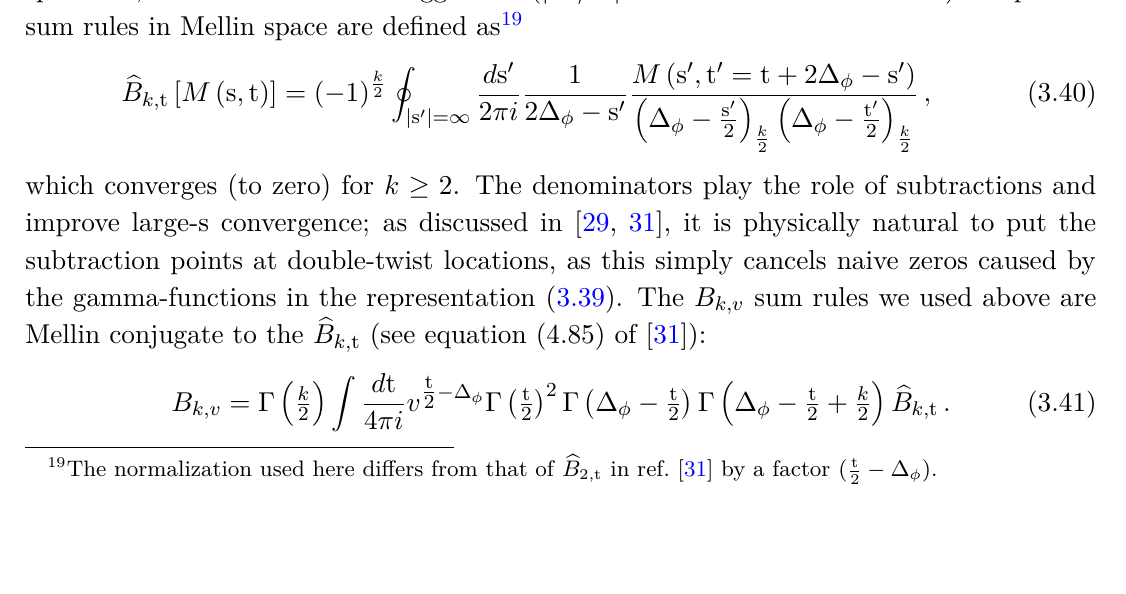
Figure 9. Interpretation of the complex saddle point (3.33) and spacelike scattering. We start with the commutator squared h [3 , 4][1 , 2] i ∼ dDisc ure 7(b). The s -channel OPE inserts a basis of intermediate states along the dashed line, which propagate horizontally along a spacelike direction. This explains why a real exponent appears in the block (3.13). Integrating the block against the oscillatory function P creates the complex saddle point which effectively interchanges space and time, thus realizing a bulk-focused scattering process 34 → 12